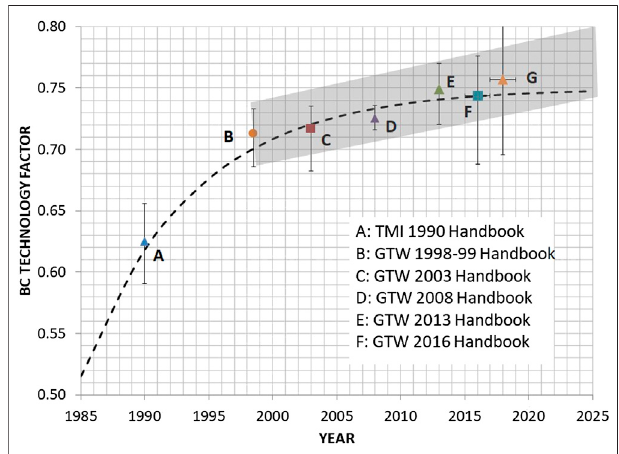
FIGURE3| GTCCRankine(see)bottomingcycleevolution,1985 – 2018. Data points are averages; error bars denote the range (min-max) in published